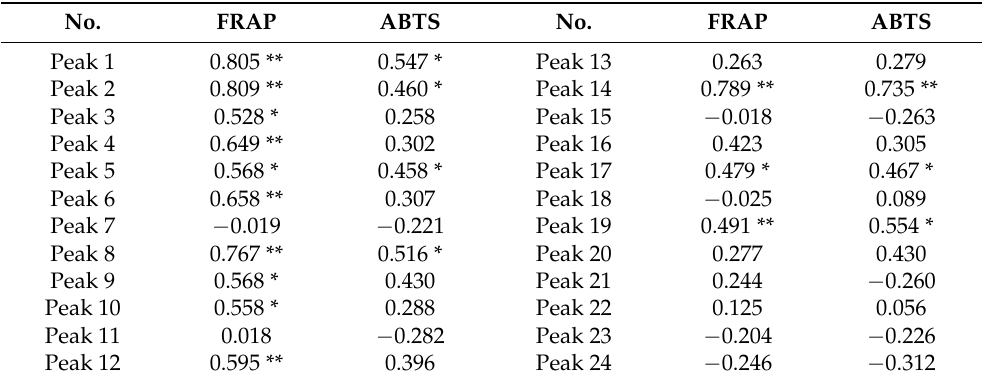
Table 4. Spearman correlation coefficient between variables and antioxidant activity data. No. FRAP ABTS No.